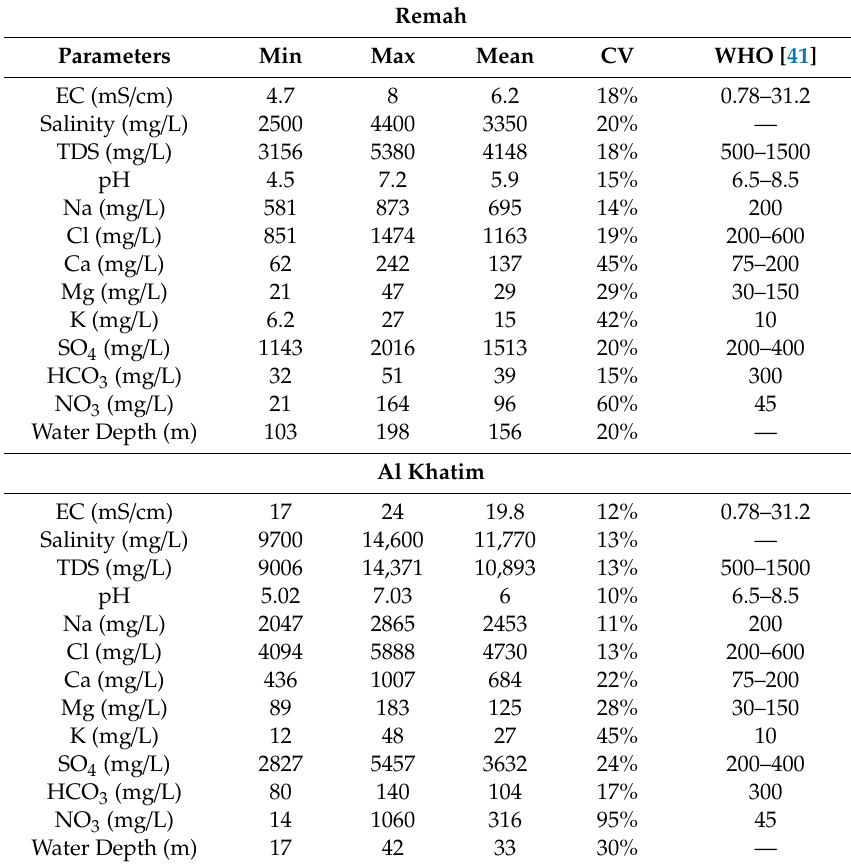
Table 1. Descriptive statistics of chemical concentration and water depth in groundwater in Remah and Al Khatim (CV: coe ffi cient of